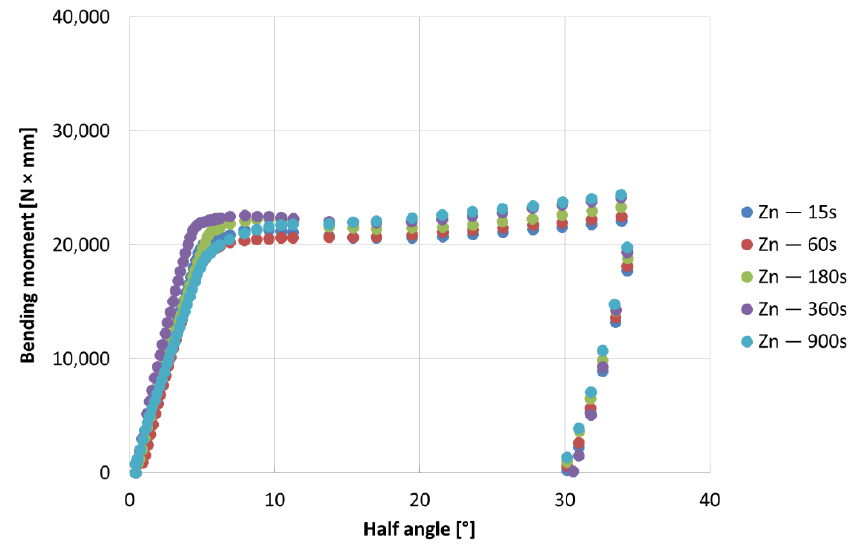
Figure 3. Bending tests results for specimens from pure Zn bath.